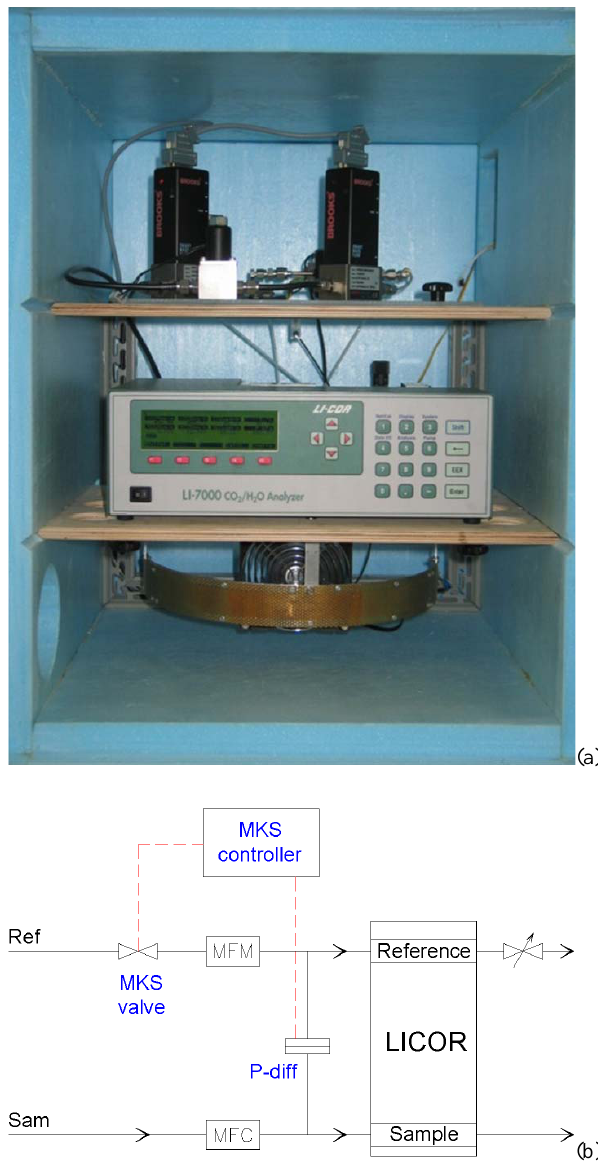
Fig. 4. (a) Schematics of the Licor gas control system (b) Licor 7000 NDIR in the isolated box (isolated front panel re- moved for picture) with temperature, flow and pressure control.